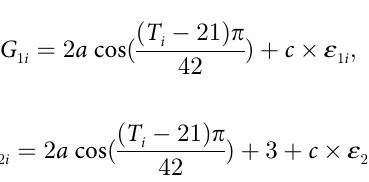
The results are similar to those of Case 1 and are summarized in Table 2. Taking both PR and FPR into account, when noise is low, K -RBF performs similarly to Pearson’s correlation c and dCor on the estimation of the nonlinear correlation in Case 2. But K -RBF has better per- c formance than Pearson’s correlation and dCor when noise is moderate. Similar to Case 1, K c with polynomial kernels and Kendall’s correlation coefficient are not suitable estimators, due to high FPRs and small and insignificant coefficients, respectively. Case 3.